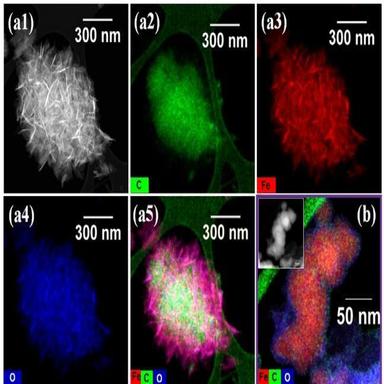
TEM/EDS images of the iron oxide flakes on 24HBC/nZVI #bIIC sample: (a1) scanned area, (a2) carbon element, (a3) iron element, (a4) oxygen element, and (a5) all the three elements. (b) TEM/EDS of nZVI particles in 24HBC/nZVI #bIIC.